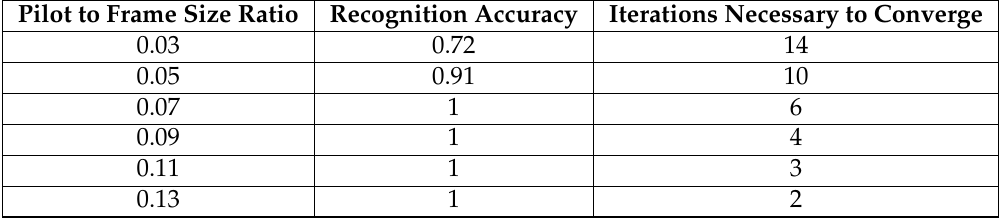
Table 2. The relationship between pilot to frame size ratio, recognition accuracy, and number of iterations necessary to converge at SNR = 14 dB.